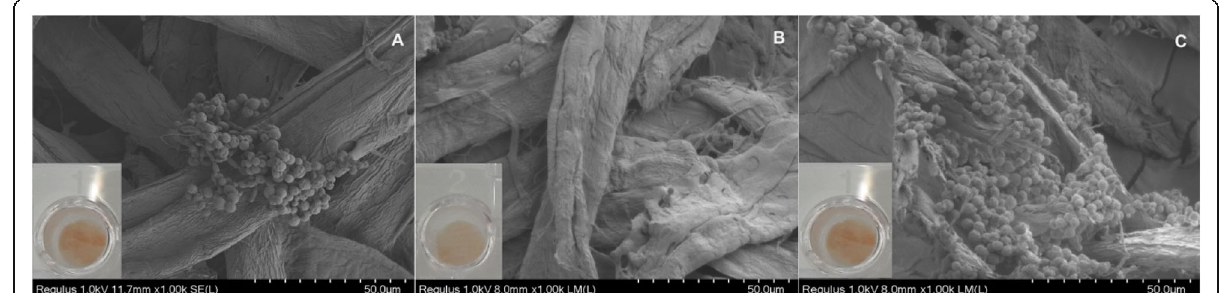
Fig. 7 SEM images of the C. albicans cells treated with farnesol alone and F-PLGA NPs on biofilm